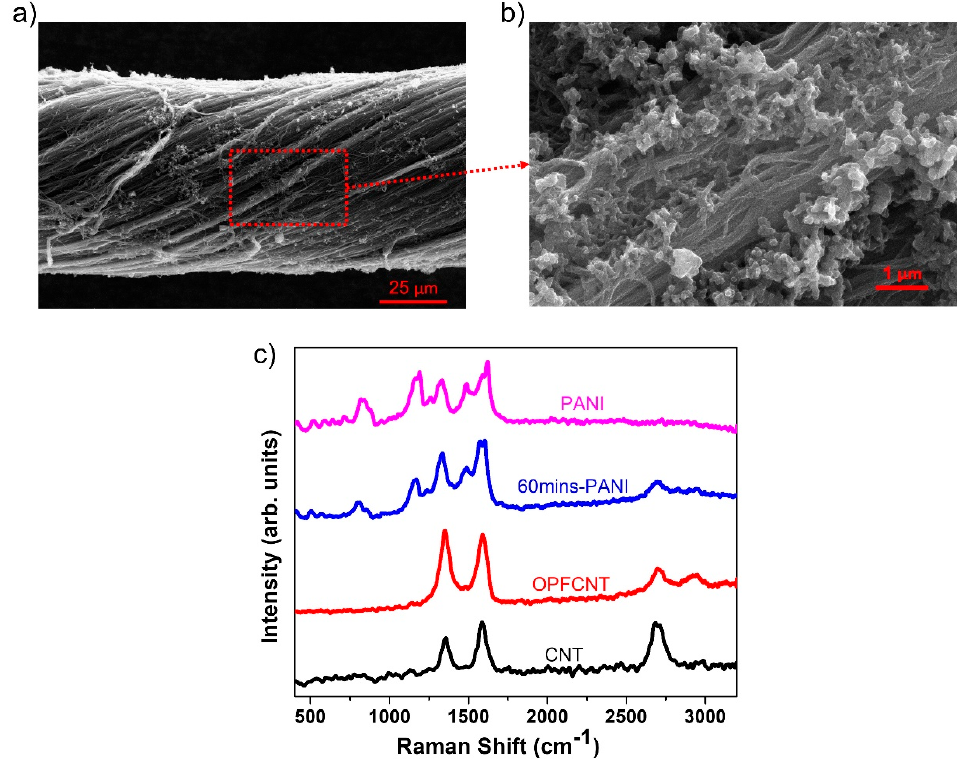
Figure 6. ( a ) SEM of 60 min PANI-CNT fiber; ( b ) enlarged image from ( a ); and ( c ) Raman of CNT, OPFCNT, 60 min PANI-CNT, and pure PANI.